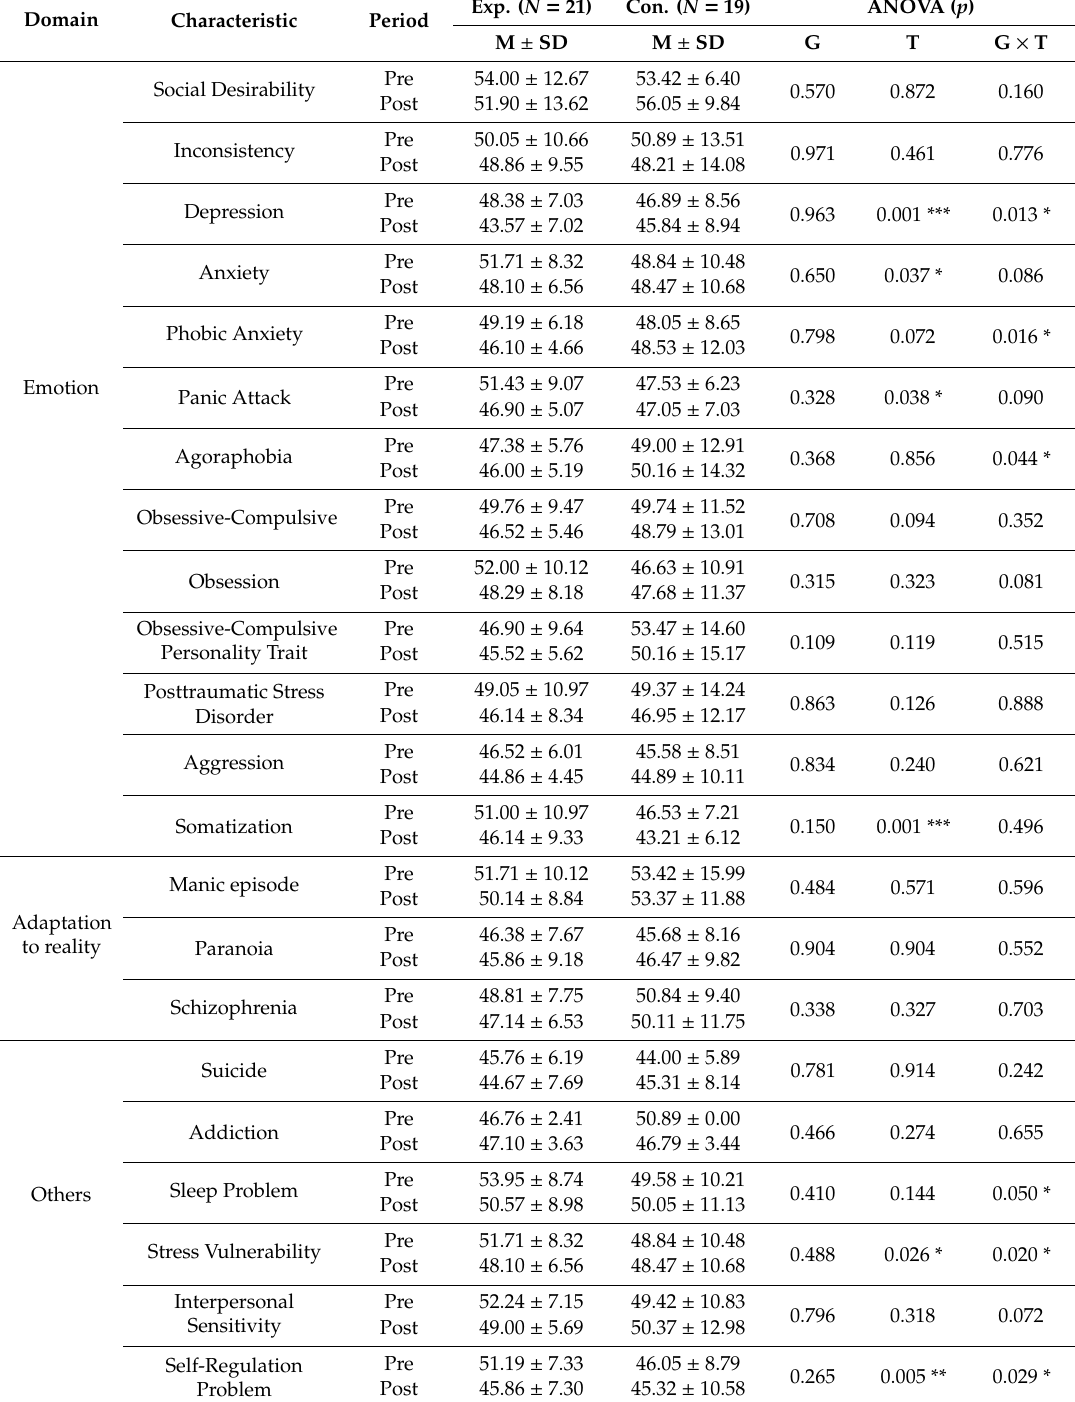
Table 5. Changes in mental health after participating in the SaBang-Dol Gi walking exercise program.